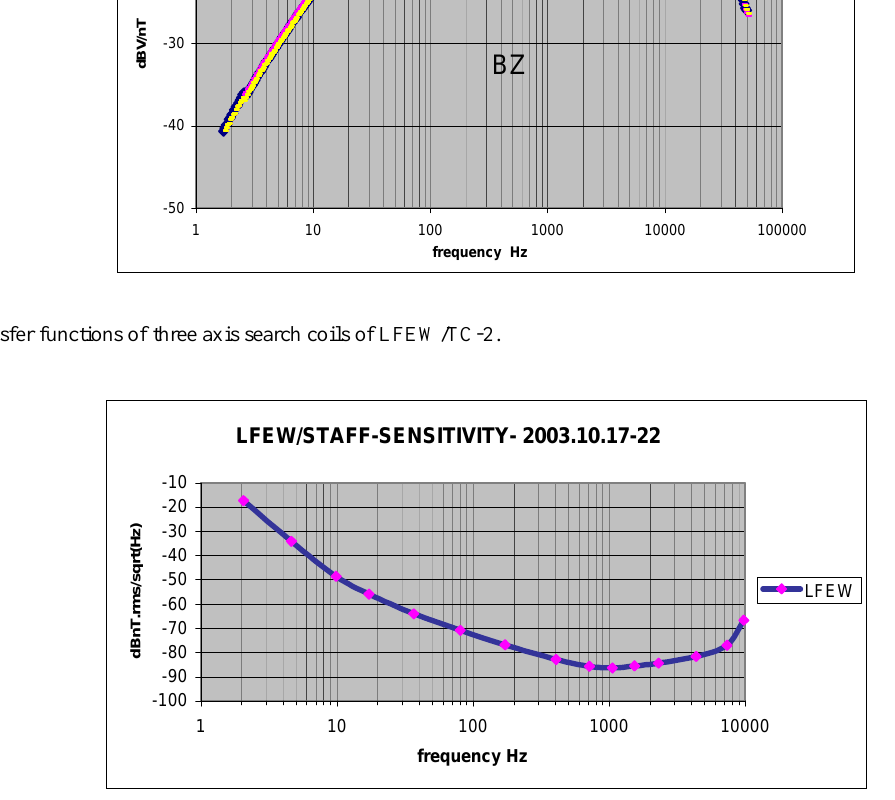
Fig. 3 The sensitivity measured in Chambon de Foret LFEW of TC-2. Fig. 3. The sensitivity measured in Chambon de Forˆet of